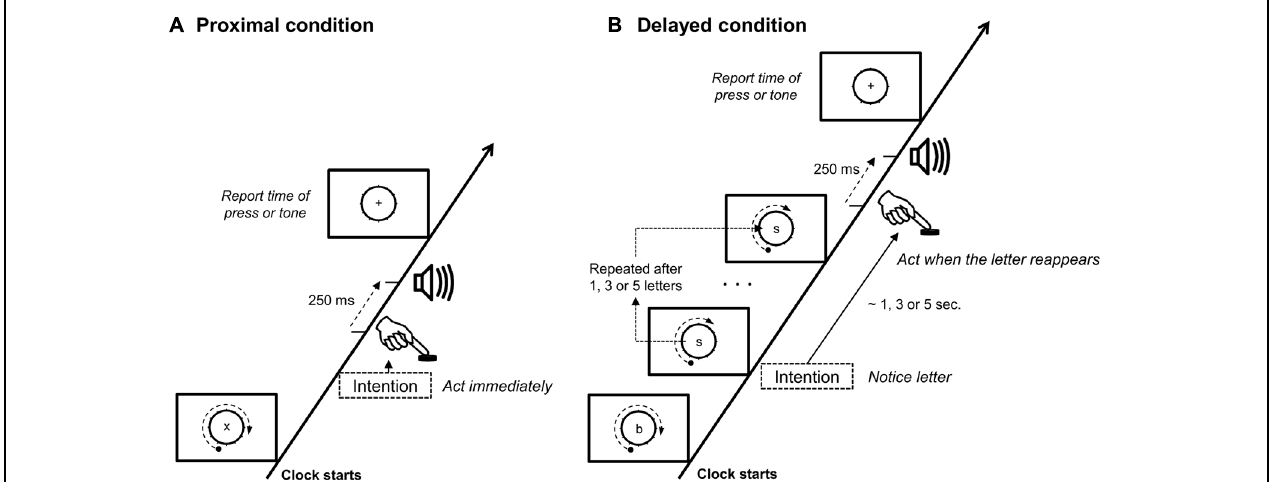
FIGURE 2 | Schematic illustration of the experimental conditions. Each trial started when the clock began to run. Letters were shown in the middle of the clock one at the time for 800 ms, followed by 200 ms blank. (A) In proximal conditions participants pressed the key as soon as they had the intention to act. (B) In the delayed conditions participant had